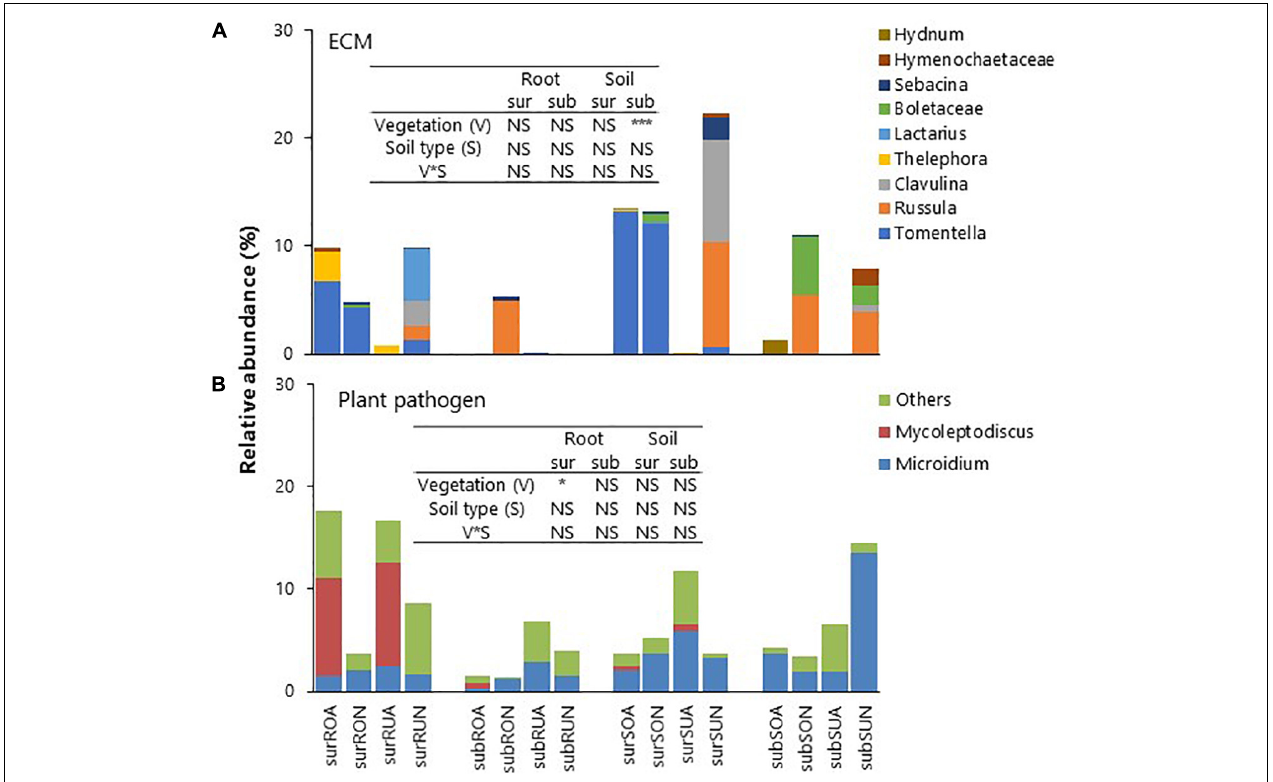
FIGURE 5 | Relative abundances of (A) ECM and (B) Plant pathogen, sur, sub, R, S, O, U, A, and N indicate surface, subsurface, Root, Soil, Oxisols, Ultisols, Acacia, and Native, respectively. NS, *, and *** in inserted tables indicate not significant, P < 0.05 and P < 0.001, respectively, by two-way